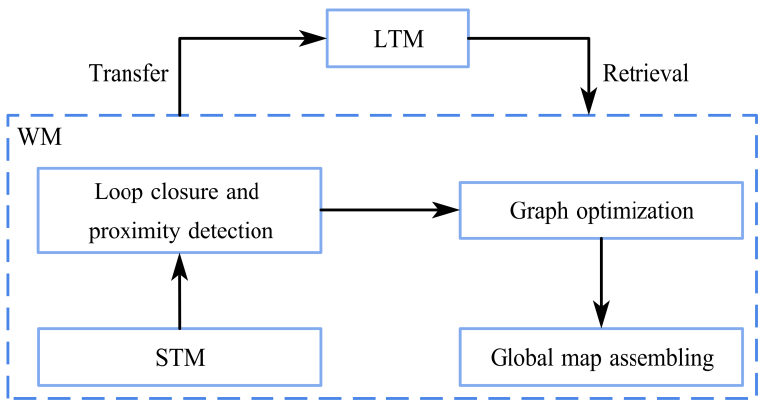
Figure 12. Memory management mechanism of RTAB-MAP.